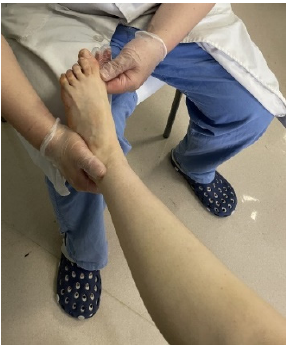
Figure 6. Manual correction of the varus of hindfoot (The first-ray becomes more flexion).